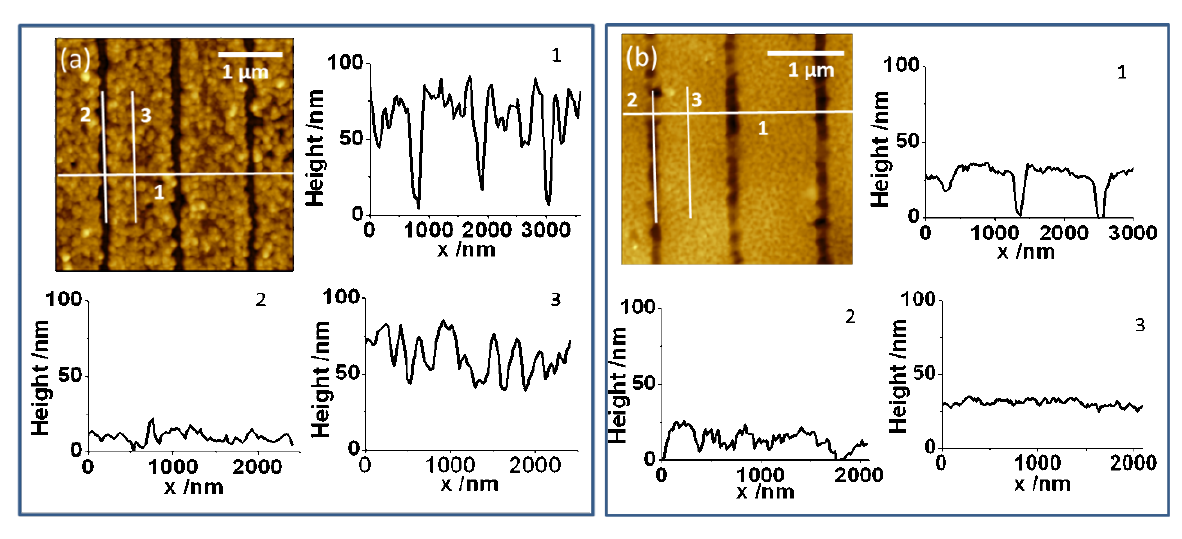
Figure 8: AFM topography images of Cu electrodeposited onto an e-beam-patterned MBP0-SAM on Au/Si (a) before and (b) after lift-off. The height profiles shown are taken along the numbered cross-sections. Lines of cross-linked MBP0 were written by using a dose of 1000 mC/cm 2 . The parame- ters for Cu deposition were − 0.7 V for 1 s, − 0.35 V for 10